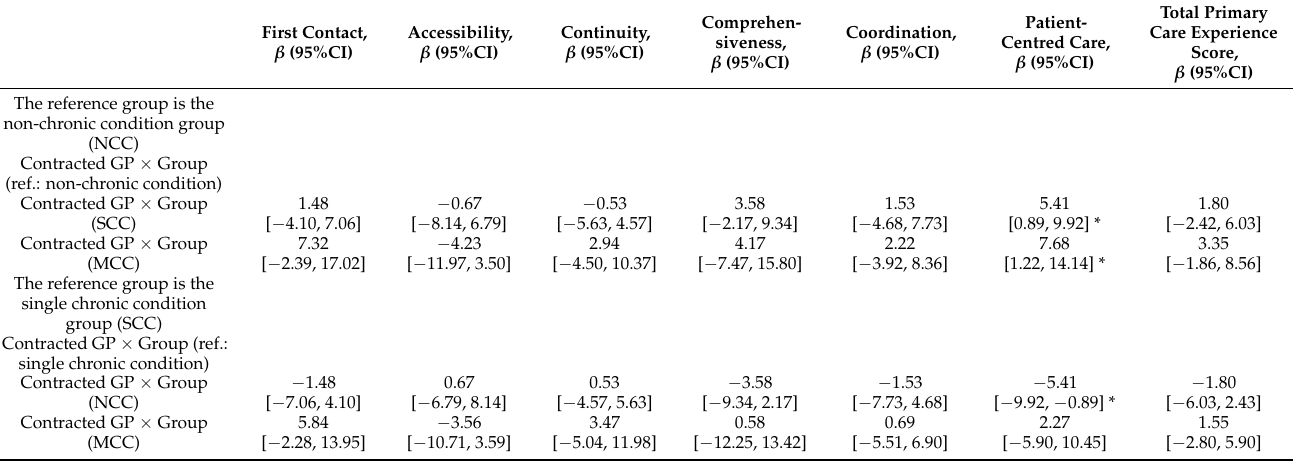
Figure 1. Forest plot of linear regressions of family practice contract services associated with in- dividual and total primary care attribute scores as the number of chronic condition increases. GP, general practitioner. 4 Mean and SE of the subgroup with and without contracted GP based on t -test. * p < 0.05, ** p < 0.01 and *** p < 0.001, based on t -test of difference between those contracted with a GP and those not contracted. The group difference was significant at the 0.05 level, based on multiple regressions results after controlling for gender, age, marital status, migrant, education, occupation, income, health status, medical insurance and period of time since the first visit. Table 3. Linear regression of family practice contract services on primary care attribute scores among the three different chronic condition groups, including